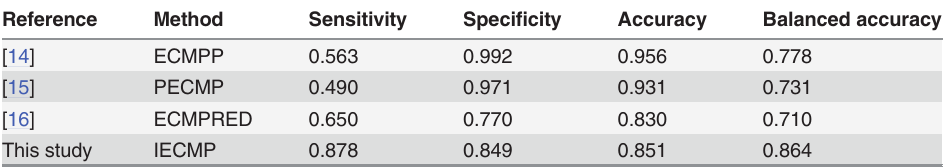
Table 6. The prediction results compared with other methods on the training dataset using 10-fold